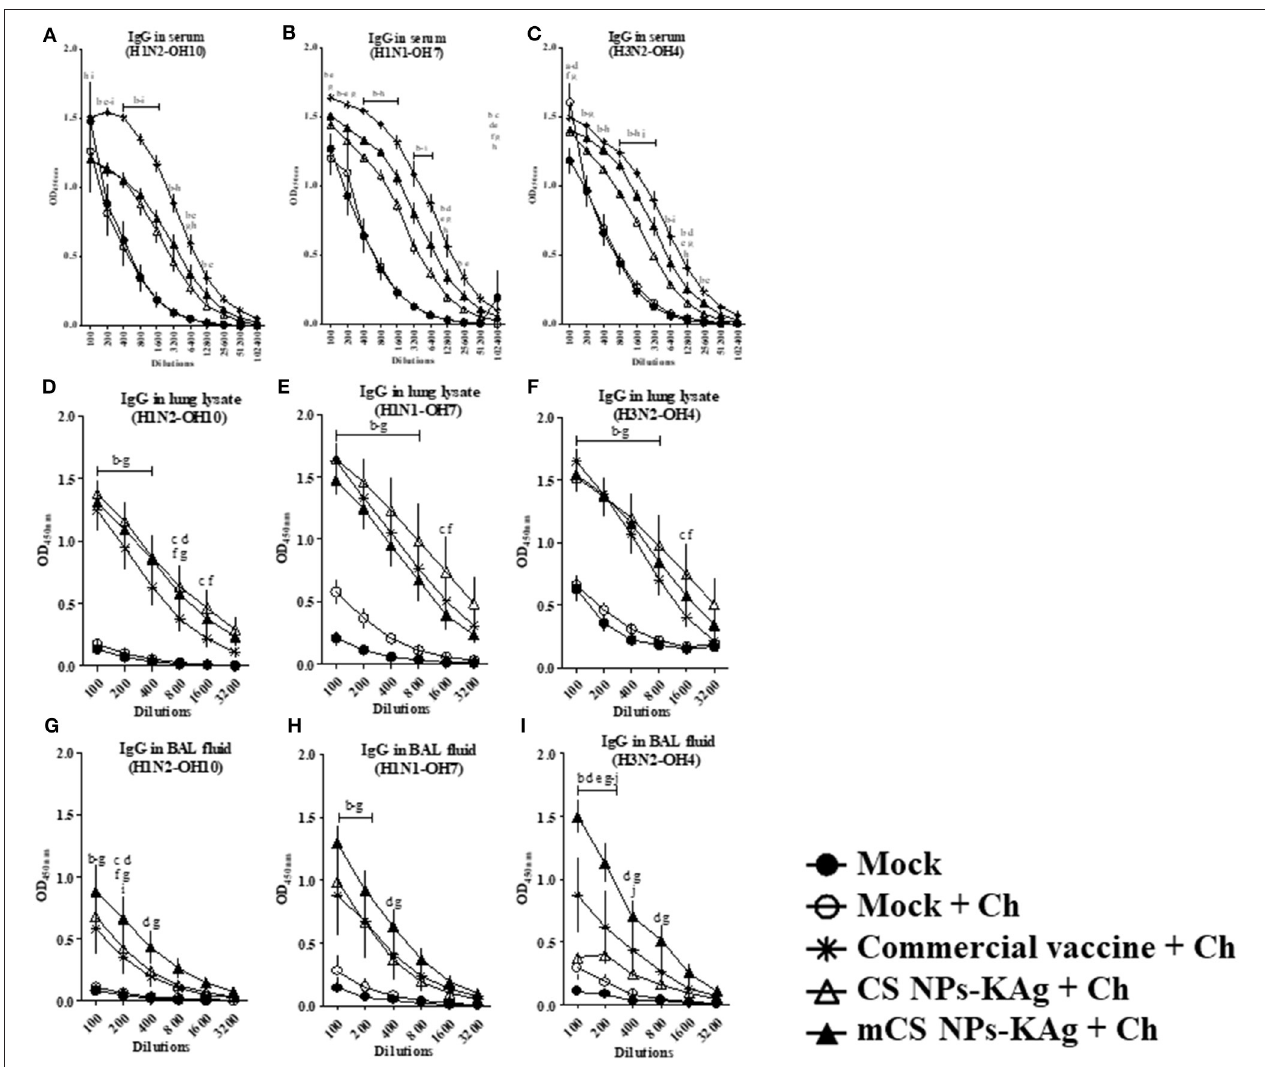
FIGURE 3 | Commercial swine flu vaccine increased the cross-reactive serum IgG, and mannose-conjugated and unconjugated CS NPs influenza (mCS NPs-KAg and CS NPs-KAg) vaccines augmented IgG antibody response in lung lysate and BAL fluid of MDA-positive pigs. Pigs were vaccinated with mCS NPs-KAg or CS NPs-KAg vaccine (containing H1N2-OH10 virus) intranasally or commercial vaccine (containing H1N1, H1N2, and H3N2 viruses) intramuscularly and at day post vaccination 35 challenged with a H1N1-OH7 virus. On day 6 post challenge IgG antibody response in serum, lung lysate and BAL fluid samples against (A,D,G) H1N2-OH10; (B,E,H) H1N1-OH7; and (C,F,I) H3N2-OH4 viruses were analyzed by ELISA. Data represent the mean value of three to four pigs ± SEM at all indicated dilutions. Statistical analysis was carried out using two-way ANOVA followed by a Bonferroni test. Each letter on the line graph indicates the significant difference between the groups at the marked sample dilution: b, c and d indicate the difference between mock group compared to commercial vaccine + Ch, CS NPs-KAg + Ch, and mCS NPs-KAg + Ch, respectively; e, f, and g indicate the difference between mock + Ch group compared to commercial vaccine + Ch, CS NPs-KAg + Ch, and mCS NPs-KAg + Ch, respectively; h and i indicate the difference between commercial vaccine + Ch compared to CS NPs-KAg + Ch and mCS NPs-KAg + Ch, respectively; j indicate the difference between CS NPs-KAg + Ch compared to mCS NPs-KAg + Ch. A p < 0.05 was considered statistically significant. Ch,